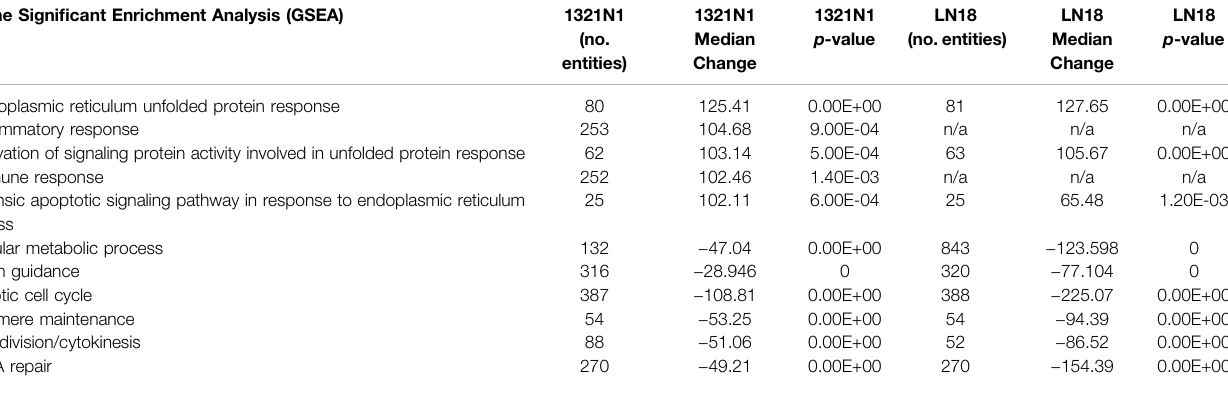
TABLE 3 | Gene set enrichment analysis (GSEA). Positive median changes imply increased biological process regulation, whereas negative median changes indicate decreased biological process regulation in cells treated with EGCG+HC vs vehicle control cells. Gene Signi fi cant Enrichment Analysis